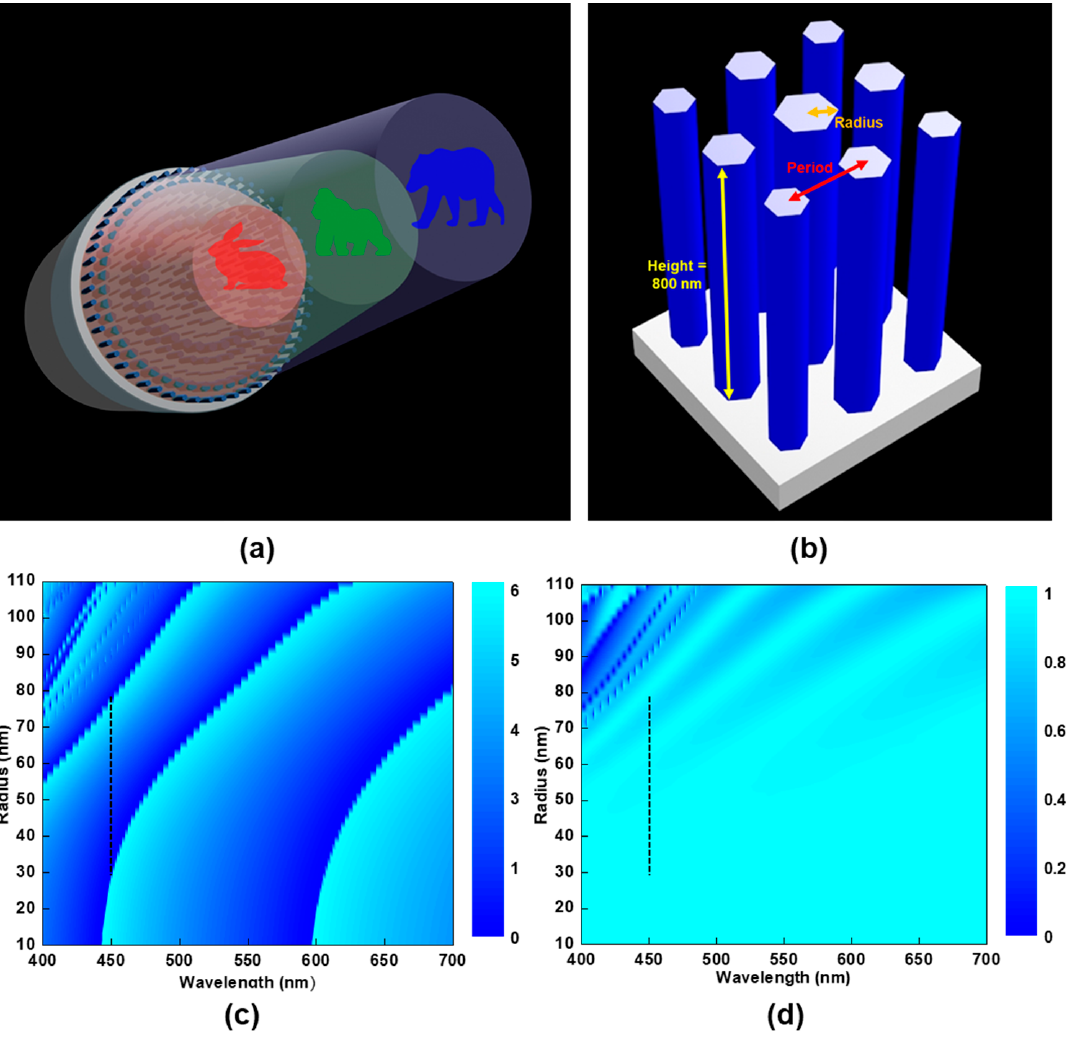
Figure 1. ( a ) Schematic describing a digital image decrypted by a metalens; ( b ) schematic showing the building blocks of the metalens; ( c ) the diagram referring to the phase modulation of the building blocks; and ( d ) simulated efficiencies corresponding to the building blocks.